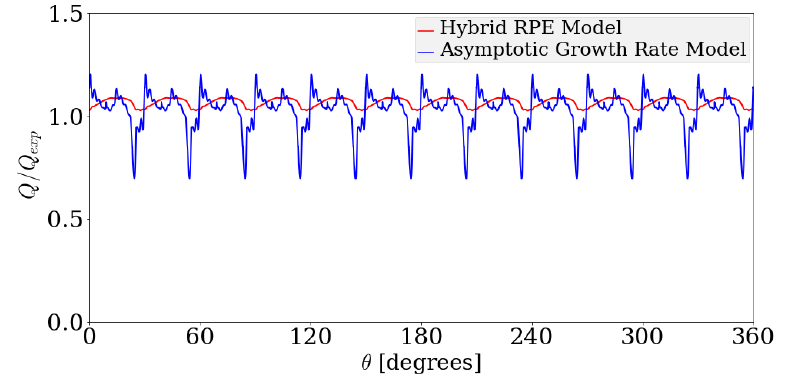
Figure 22. Comparison between delivery flow rates for the Asymptotic Growth Rate model and the Hybrid Rayleigh–Plesset Solution approach, for an operating speed of 1000